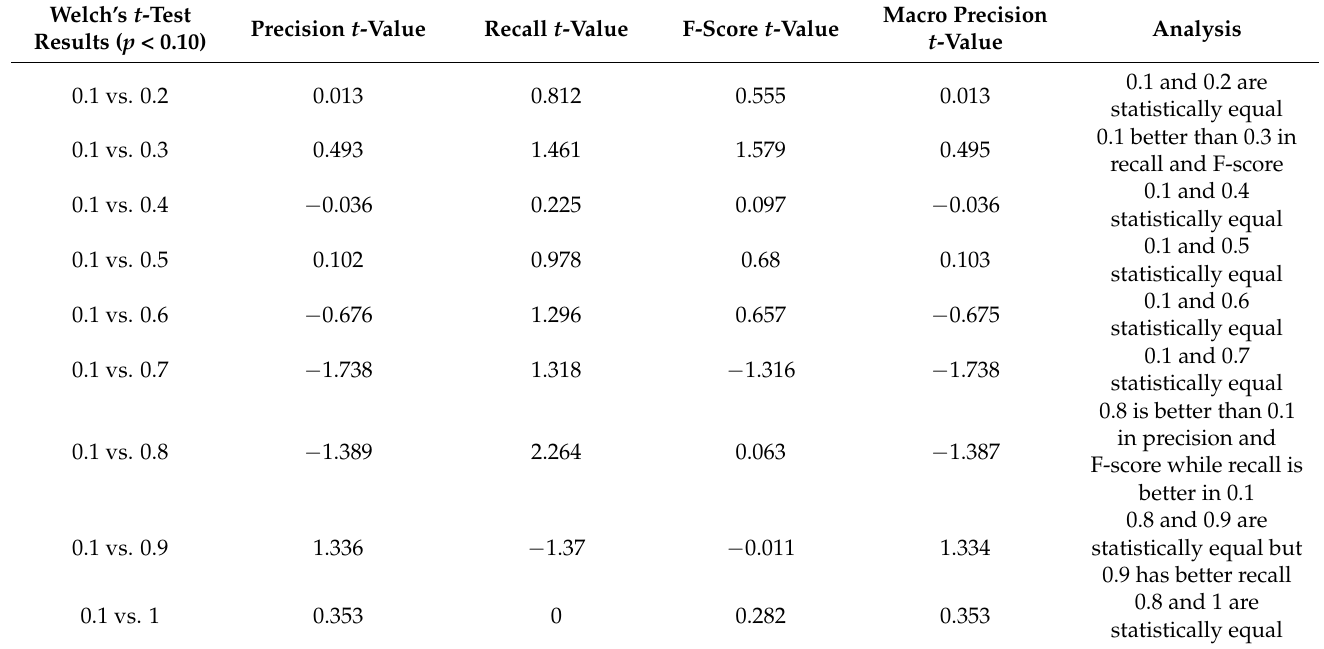
Table 20. Welch’s t -test results: UNSW-NB15: Backdoors—random undersampling after splitting.